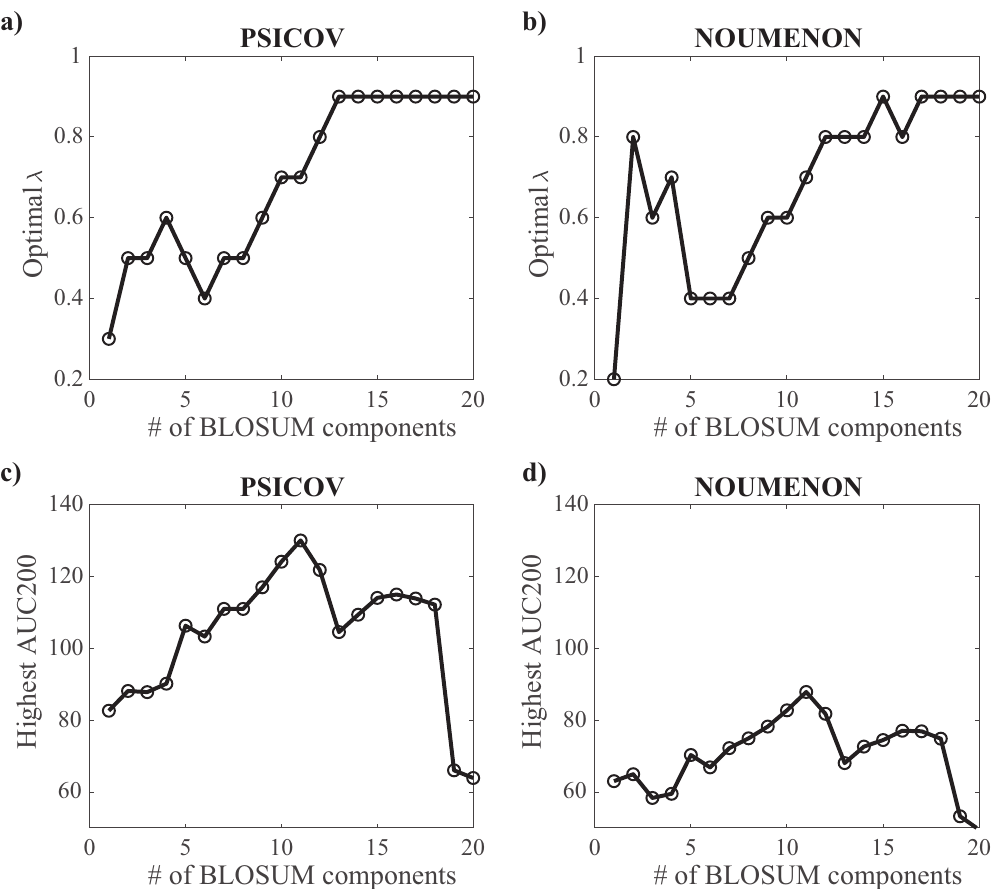
Figure 6. Parameterizing GaussCovar using a BLOSUM62-based encoding of amino acids. ( a , b ) The value of λ , the parameter controlling the amount of uniform prior included in the Gaussian model (see Equation (7)) that leads to optimal performance is plotted against the number of components for the vector representation of amino acids derived from the BLOSUM62 matrix, based on the PSICOV dataset ( a ), and based on the NOUMENON dataset ( b ). ( c , d ) The optimal AUC200 (over all predicted contacts) is given against the same number of components for the PSICOV dataset ( c ) and the NOUMENON dataset ( d